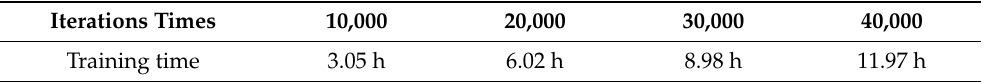
Table 2. Iterations and training time of the deep learning model using Faster